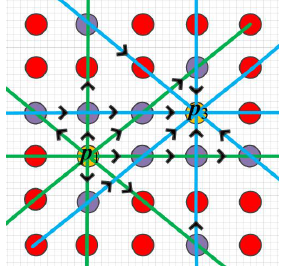
Figure 4. Paths after Two